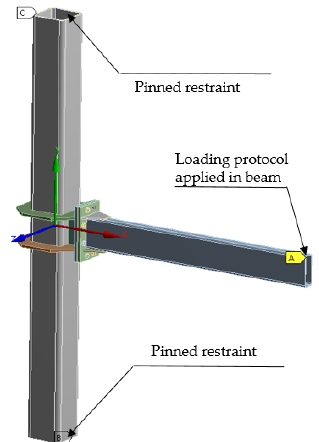
Figure 11. Boundary conditions in numerical model. Table 6. Type of contacts used in the numerical